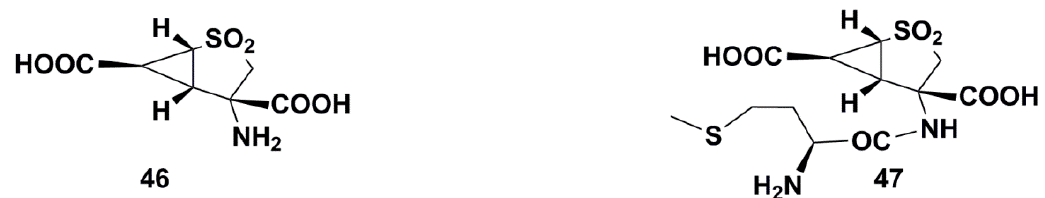
Figure 3. Structures of synthetic derivatives of glutamic acid ( 46 , 47